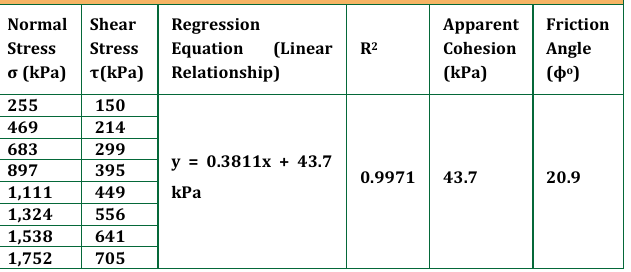
Table 3: Strength parameters of polished conglomerate core from plots of normal stress versus shear stress (at 1-3 mm displacement).